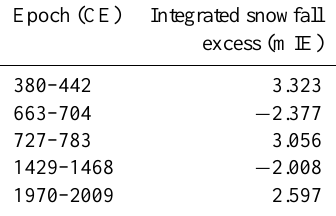
Table 1. Integrated snowfall excess (Eq. 5) based on the 10-year low-pass filtered power-law-based DSS snowfall record. Positive values indicate a period with above-average low-pass filtered snow- fall. Only integrated excesses larger in magnitude than 2mIE are shown.